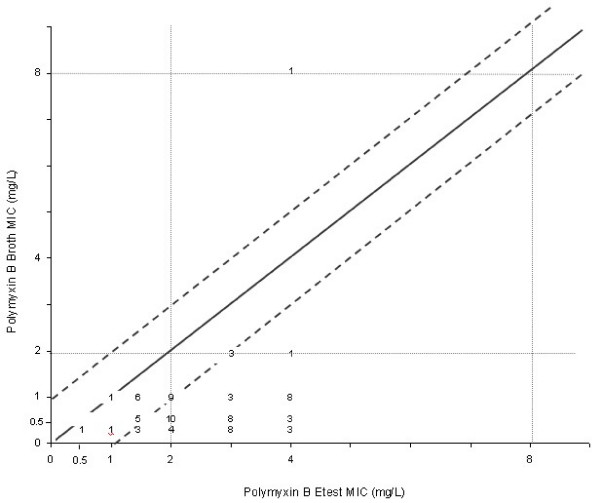
Scattergram results comparing polymyxin B MICs determined by Etest with those by the broth microdilution reference method (n = 78). The diagonal black line represents complete agreement, and the numbers represent the occurrences observed at each point. The broken lines represent ± 1-log2 MIC agreement limits between test results. Horizontal and vertical broken lines indicate the resistant MIC breakpoint ≥8 mg/L) [10].